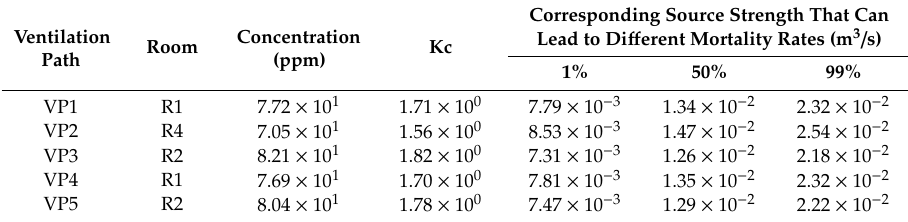
Table 2. The corresponding source strengths calculated by the highest concentration room when the pollutant source is leaked at y = 0 W.